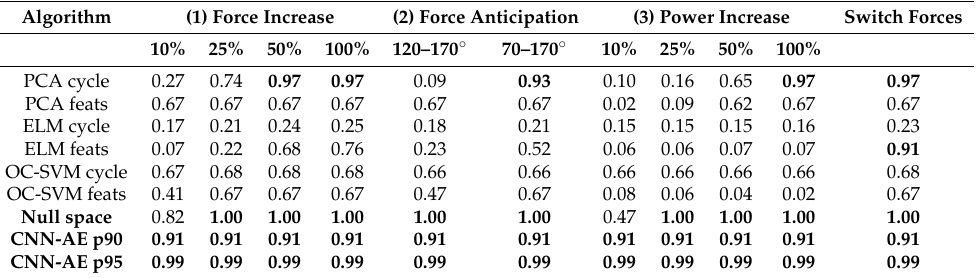
Table 4. F1 score of anomaly detection models trained under the assumption that at least 90% of training data is correct. CNN-AE’s p90 and p95 refer to the threshold used for anomaly detection, indicating percentile 90 and percentile 95 of correct validation data,